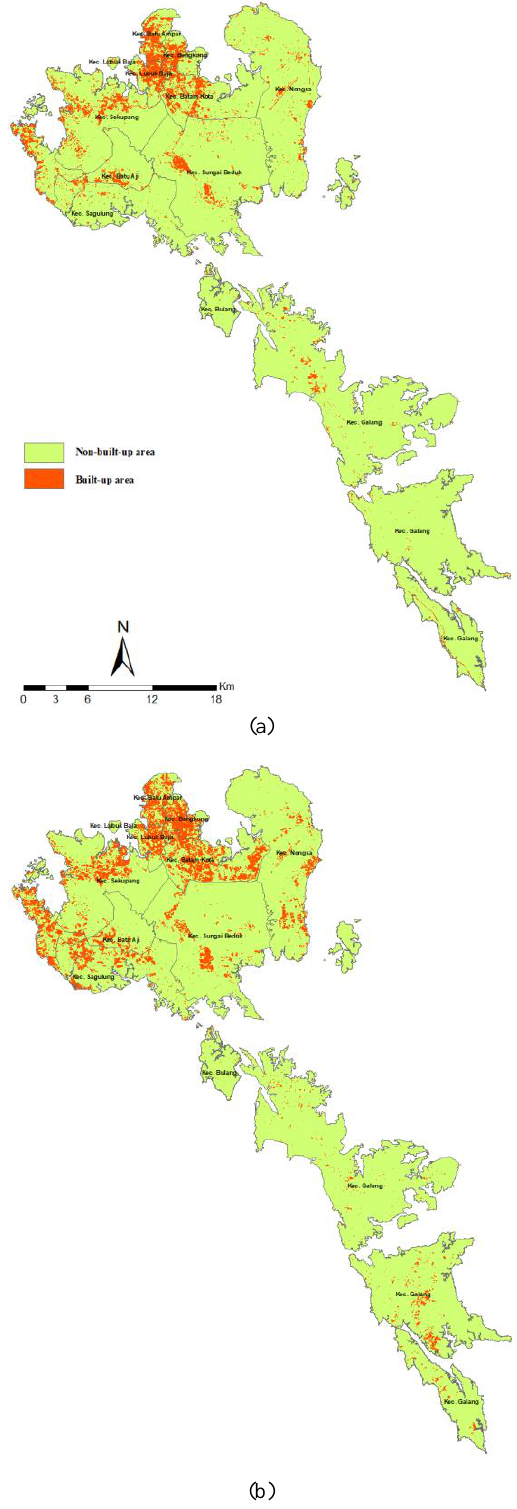
Figure 1. Land cover maps in (a) 2000 and (b) 2015.